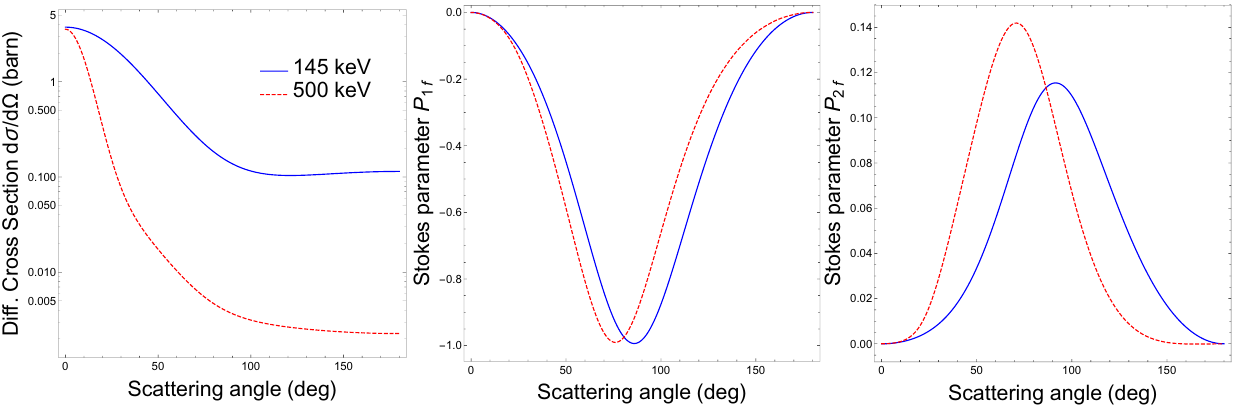
Figure 2. Rows from left to right: Differential cross sections and Stokes parameters P 1 f and P 2 f for the Rayleigh scattering of 145 keV (red dashed line) and 500 keV (blue solid line) circularly polarized photons off a lead target atom. The theoretical predictions are presented as a function of the polar photon scattering angle θ .